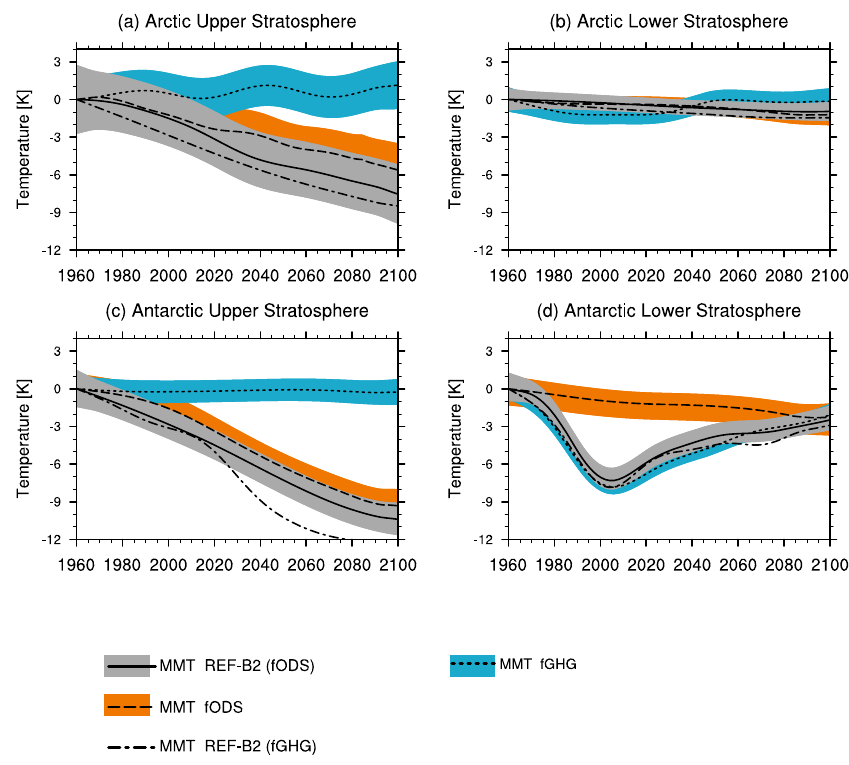
Fig. 9. Same as Fig. 8, but for